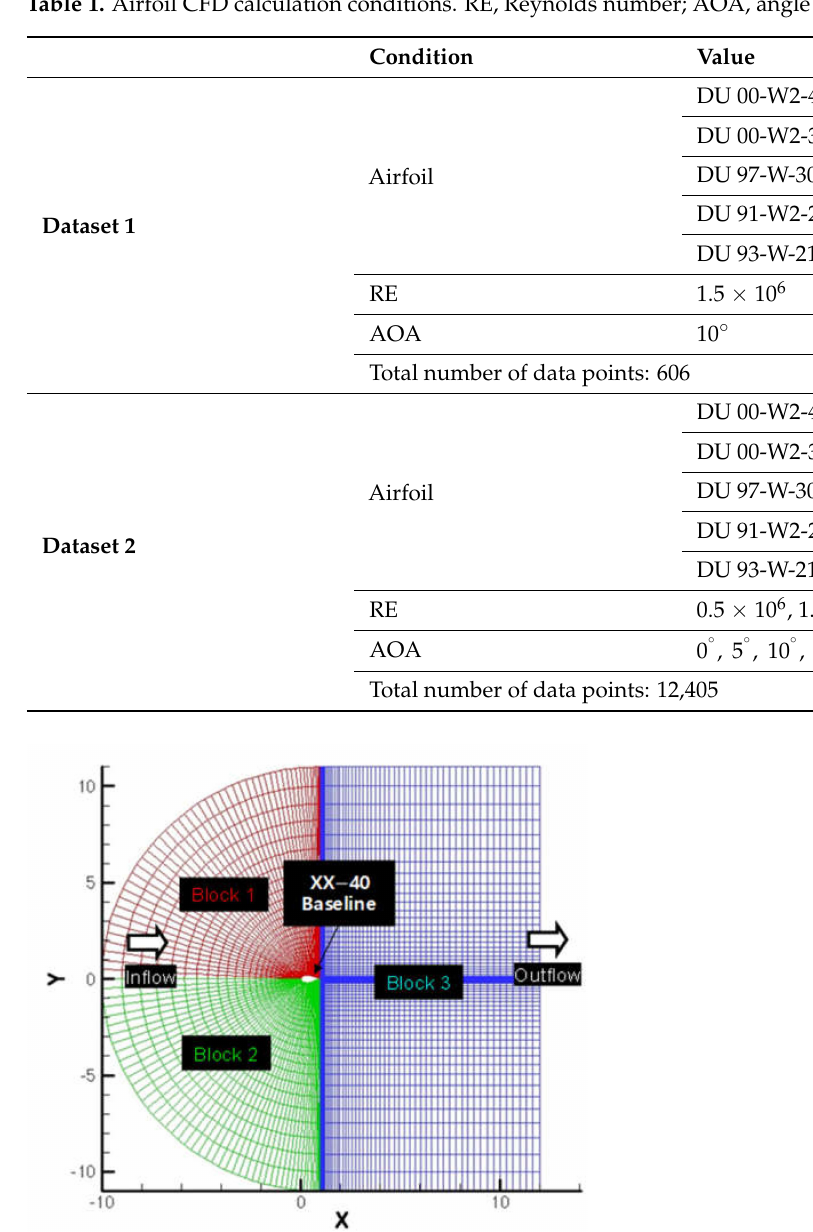
Table 1. Airfoil CFD calculation conditions. RE, Reynolds number; AOA, angle of attack.